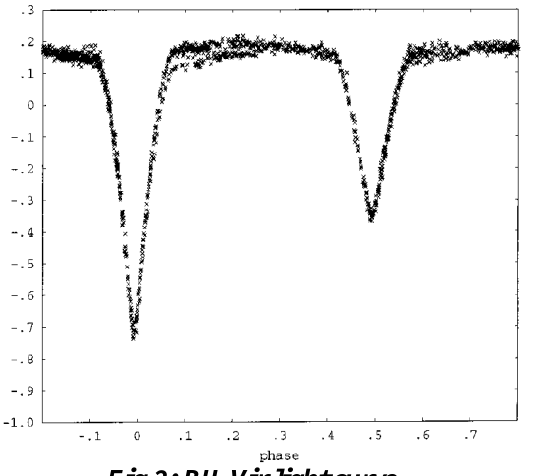
Fig.2: BH Vir light curve.